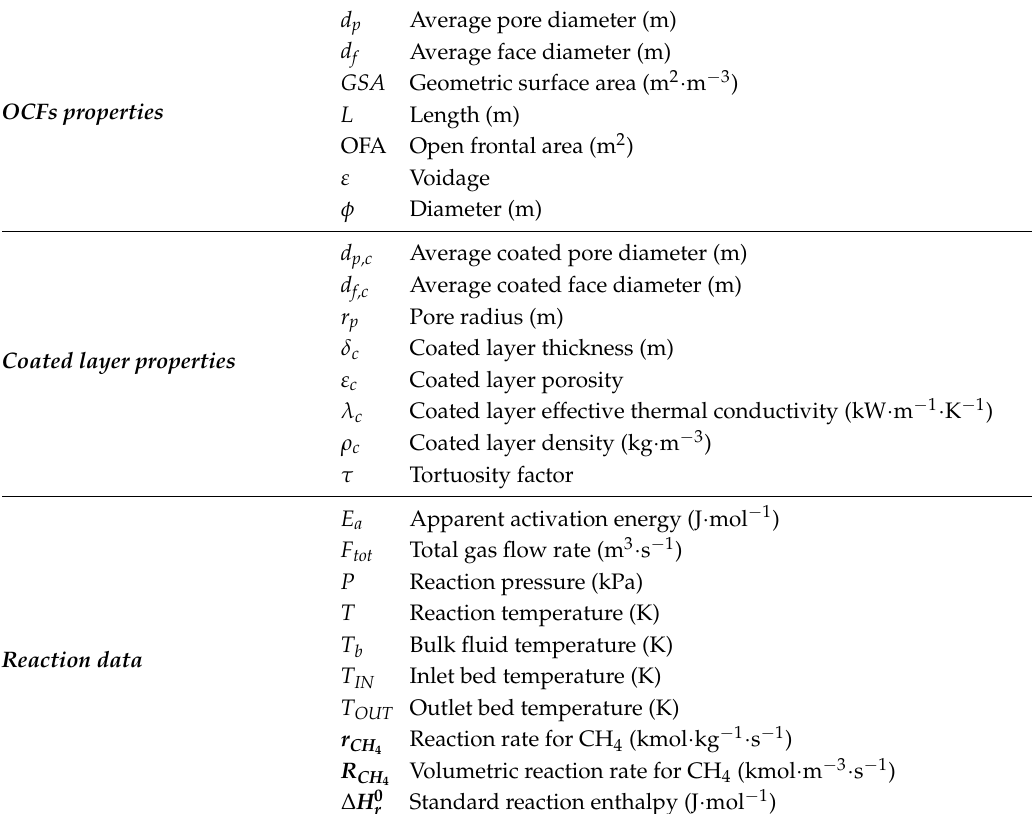
Figure S1. SEM micrographs of bare (a,c,e) and Rh/CeO 2 -coated (b,d,f) OCFs: F20 (a,b), F30 (c,d) and F40